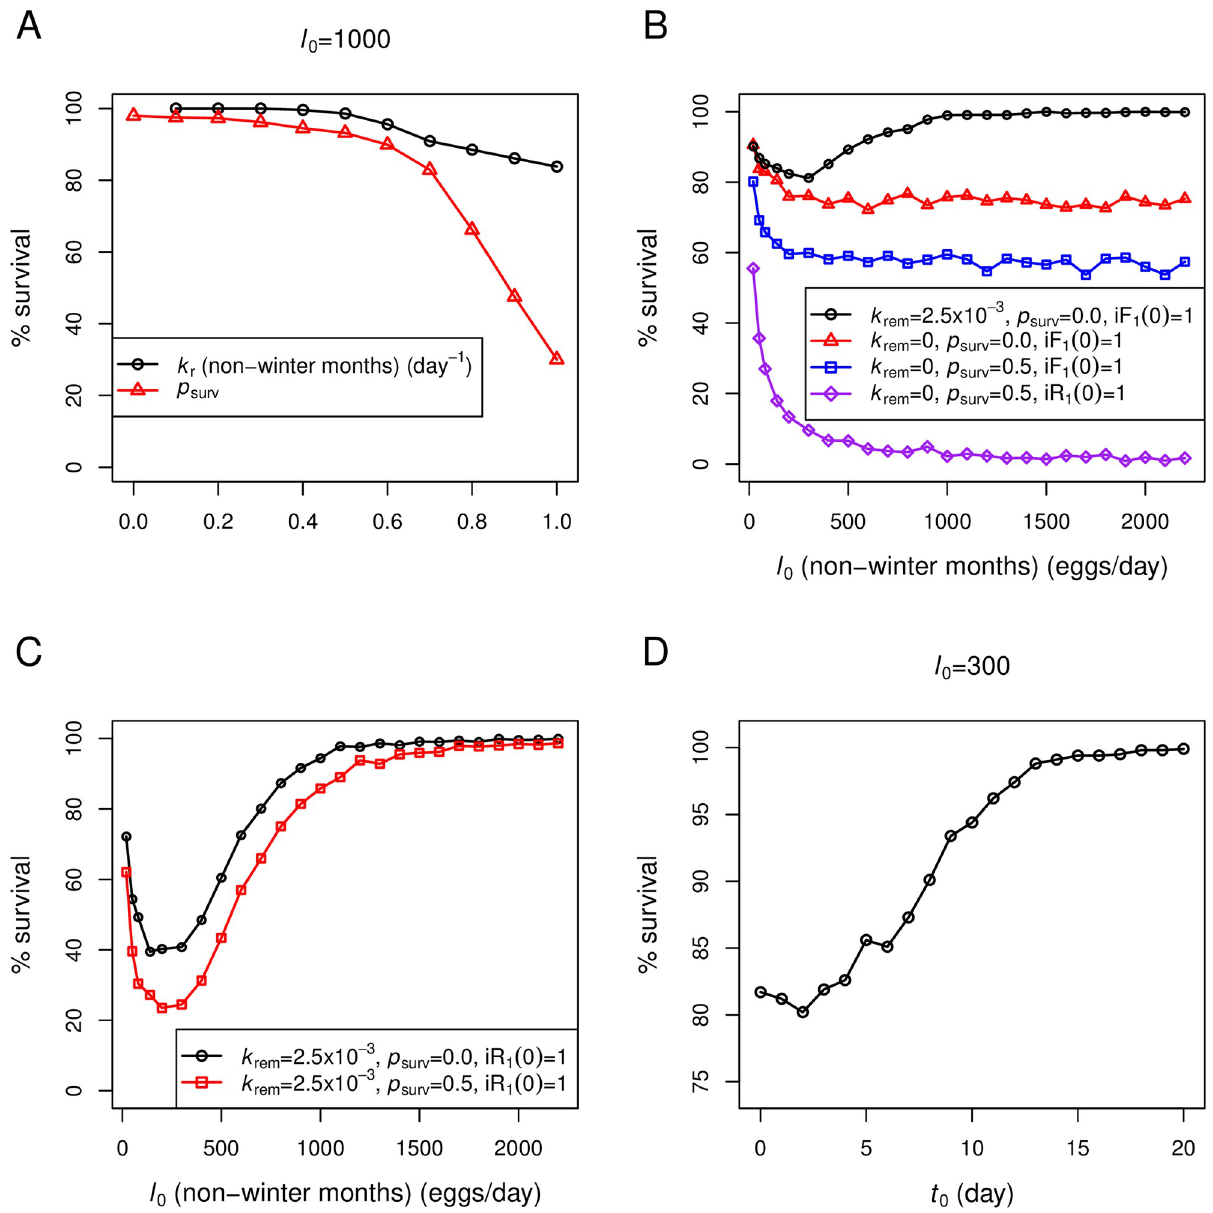
Fig 8. Percentages of survived colonies from stochastic simulations. Percentages of survived colonies are calculated from 1000 repeats of stochastic simulations. Model parameters are from Table 1, except those that are listed in each figure panel. Seasonal effects are implemented as described in the main text. A: k r during non-winter months (black line) or p surv (red line) is varied. B and C: l 0 during non-winter months is varied. D: The timing of an infection ( t 0 ) is varied in relation to the onset of spring (i.e., iF 1 ( t 0 ) =